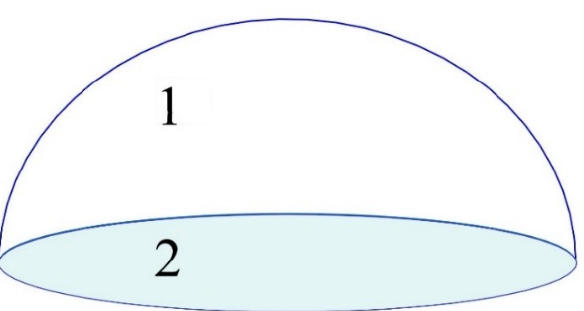
Figure 5. The second radiation principle of Cabeza-Lainez form-factors applied to a hemisphere. (cid:3002) (cid:3118) (cid:2869) 𝐹 (cid:3404) (cid:3404) , and the amount of energy from the hemisphere to itself, F 11 is also ½ [8]. (cid:2869)(cid:2870) (cid:2870) (cid:3002) (cid:3117)